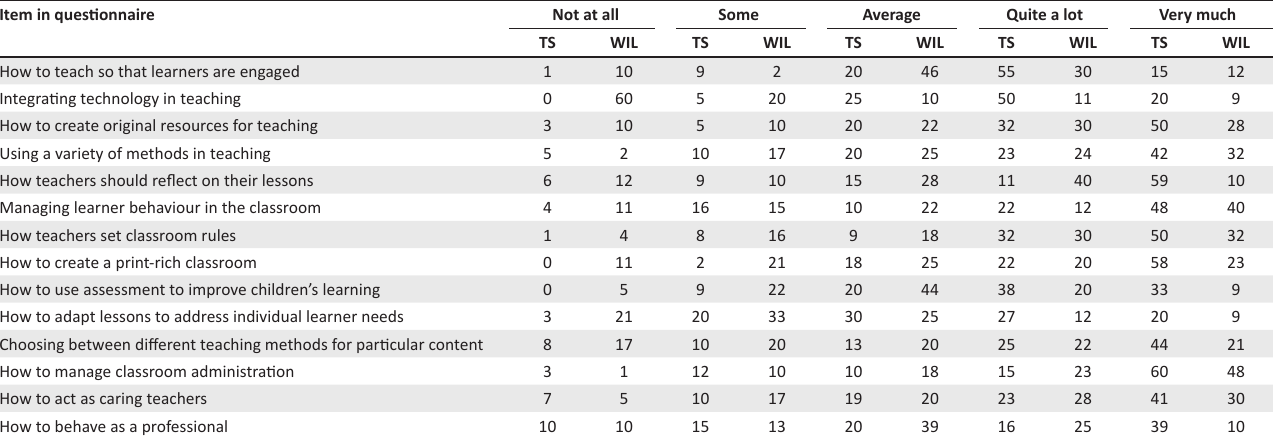
TABLE 1: Frequency of responses: The views of student teachers ( n = 100) on how much they learned in the teaching school and work integrated learning schools, respectively. Item in questionnaire